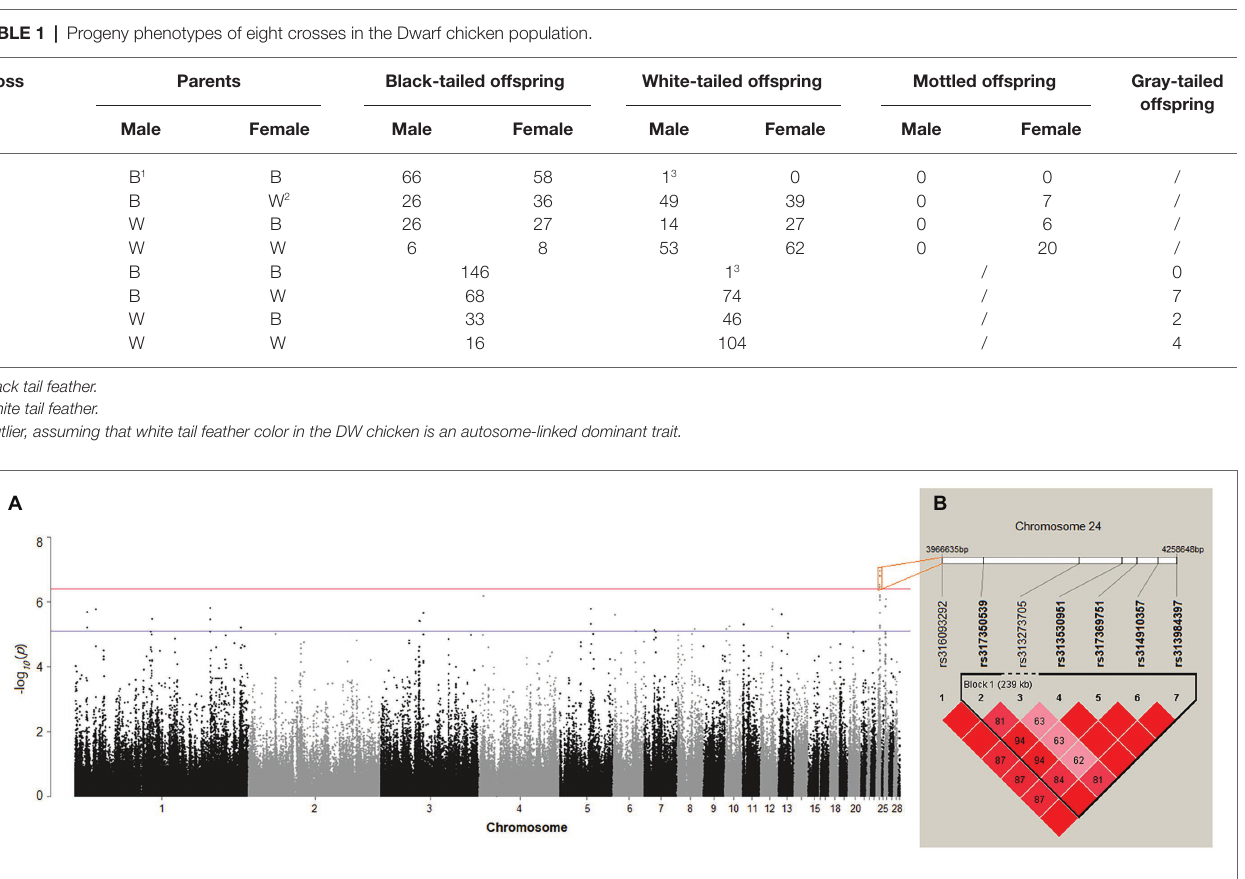
FIGURE 4 | (A) Manhattan plot showing the association of all single-nucleotide polymorphisms (SNPs) with the tail feather color (white/black) trait of Dwarf and Rhode Island Red chickens. SNPs were plotted on the x -axis according to their position on each chromosome against their association with these traits on the y -axis (shown as − log10 p -values). The red and blue lines indicate the genome-wide and suggestive significant association with p -values of 3.97 × 10 −7 (0.05/125,985) and 7.94 × 10 −6 (1/125,985), respectively. (B) Linkage disequilibrium (r2) plot association with white/black tail feather